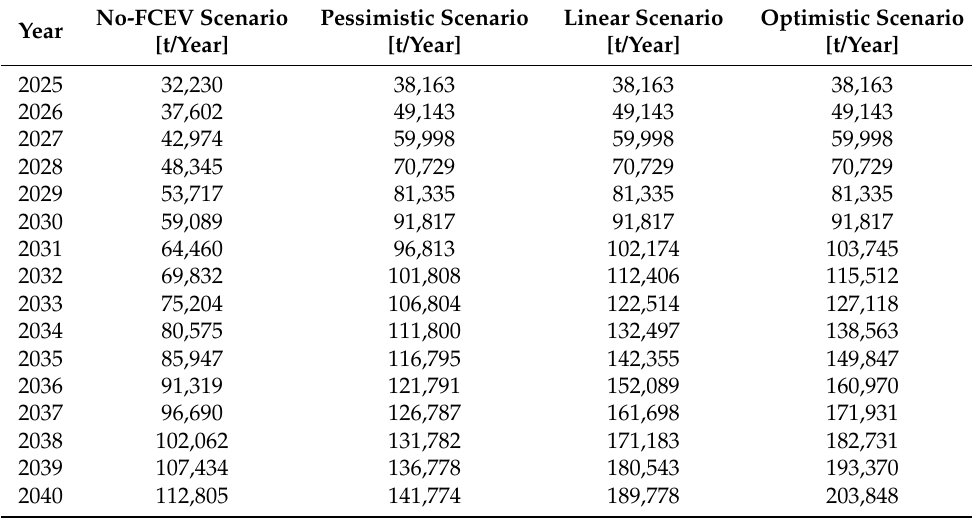
Table 7. Estimated CO 2 emission reduction, w.r.t. 2019 [4].